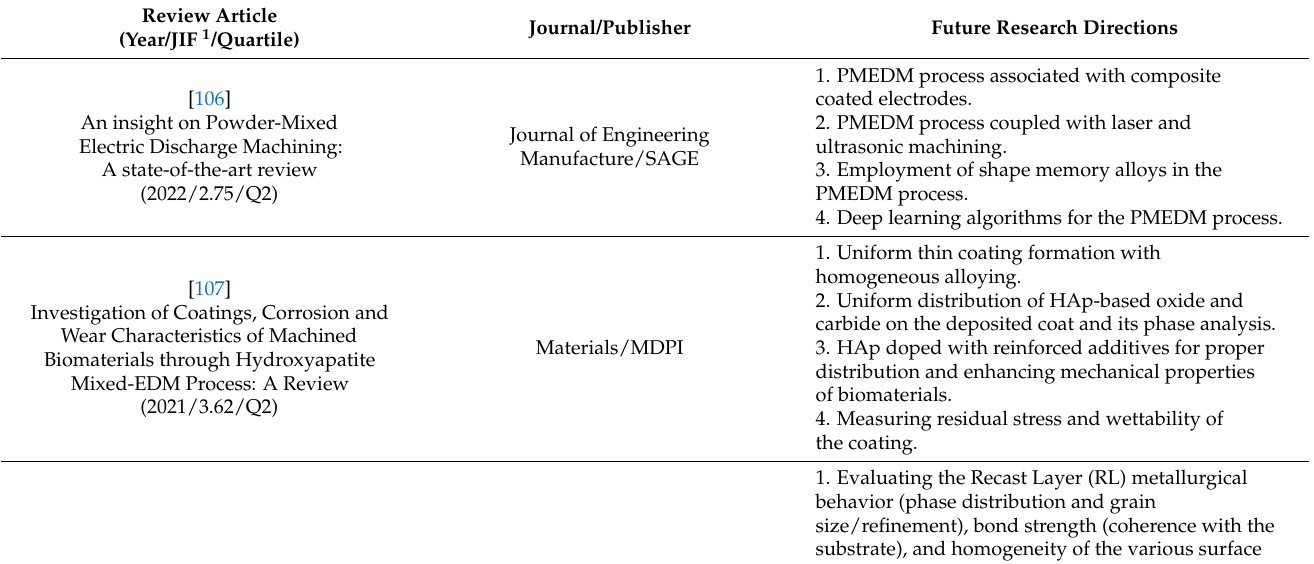
Table 4. Review articles on the PMEDM process over the past